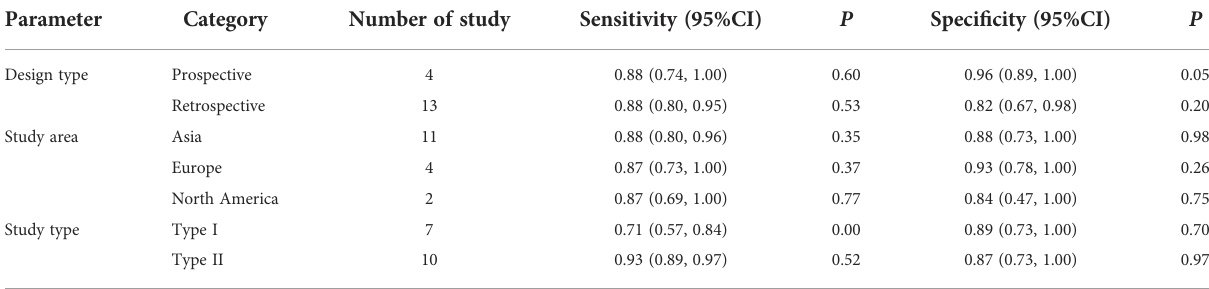
TABLE 3 Results of meta-regression